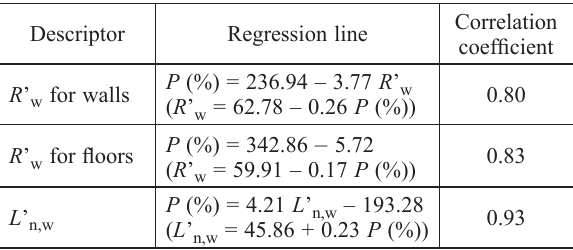
Table 3. Results of regression analysis using data from Figures 5–7 adopted for Lithuanian case